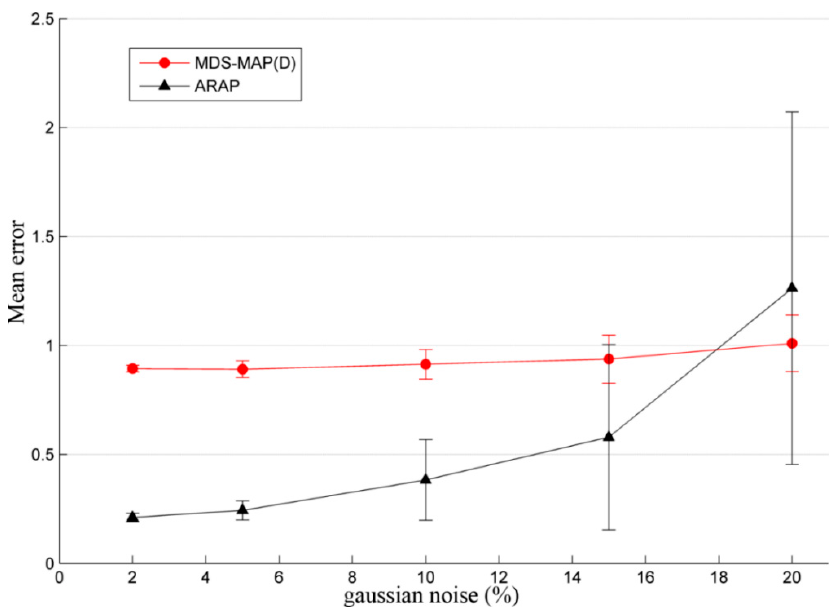
Figure 10. Mean error as a function of the added noise in the pairwise distances. Vertical bars indicate the sum and difference of the standard deviation of the mean error, i.e., the dispersion of the mean error considering all the iterations in the Monte-Carlo simulation.